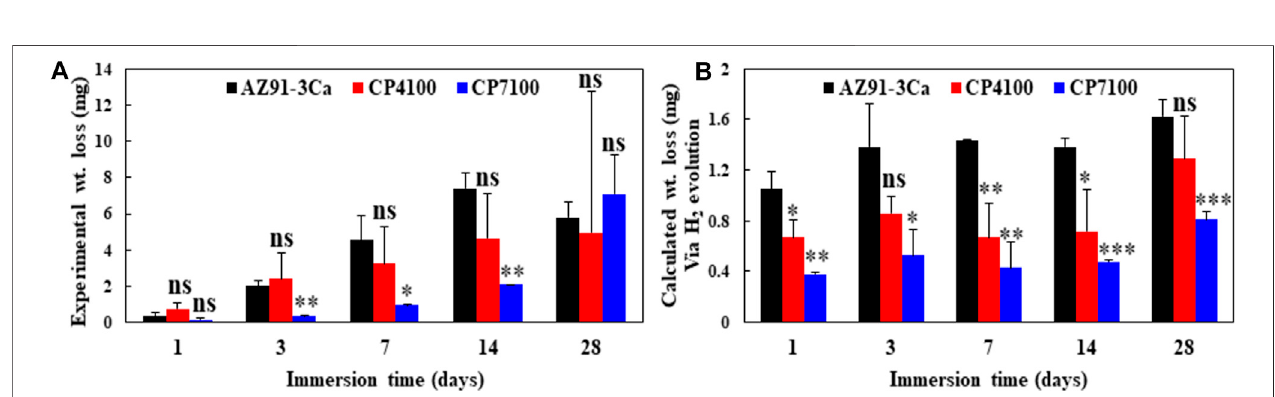
FIGURE 7 | Material degradation at different immersion times (A) Experimentally calculated weight loss of coated and uncoated AZ91-3Ca alloy (B) Weight loss of coated and uncoated AZ91-3Ca alloy calculated using Eq. 1 and H 2 evolution data.